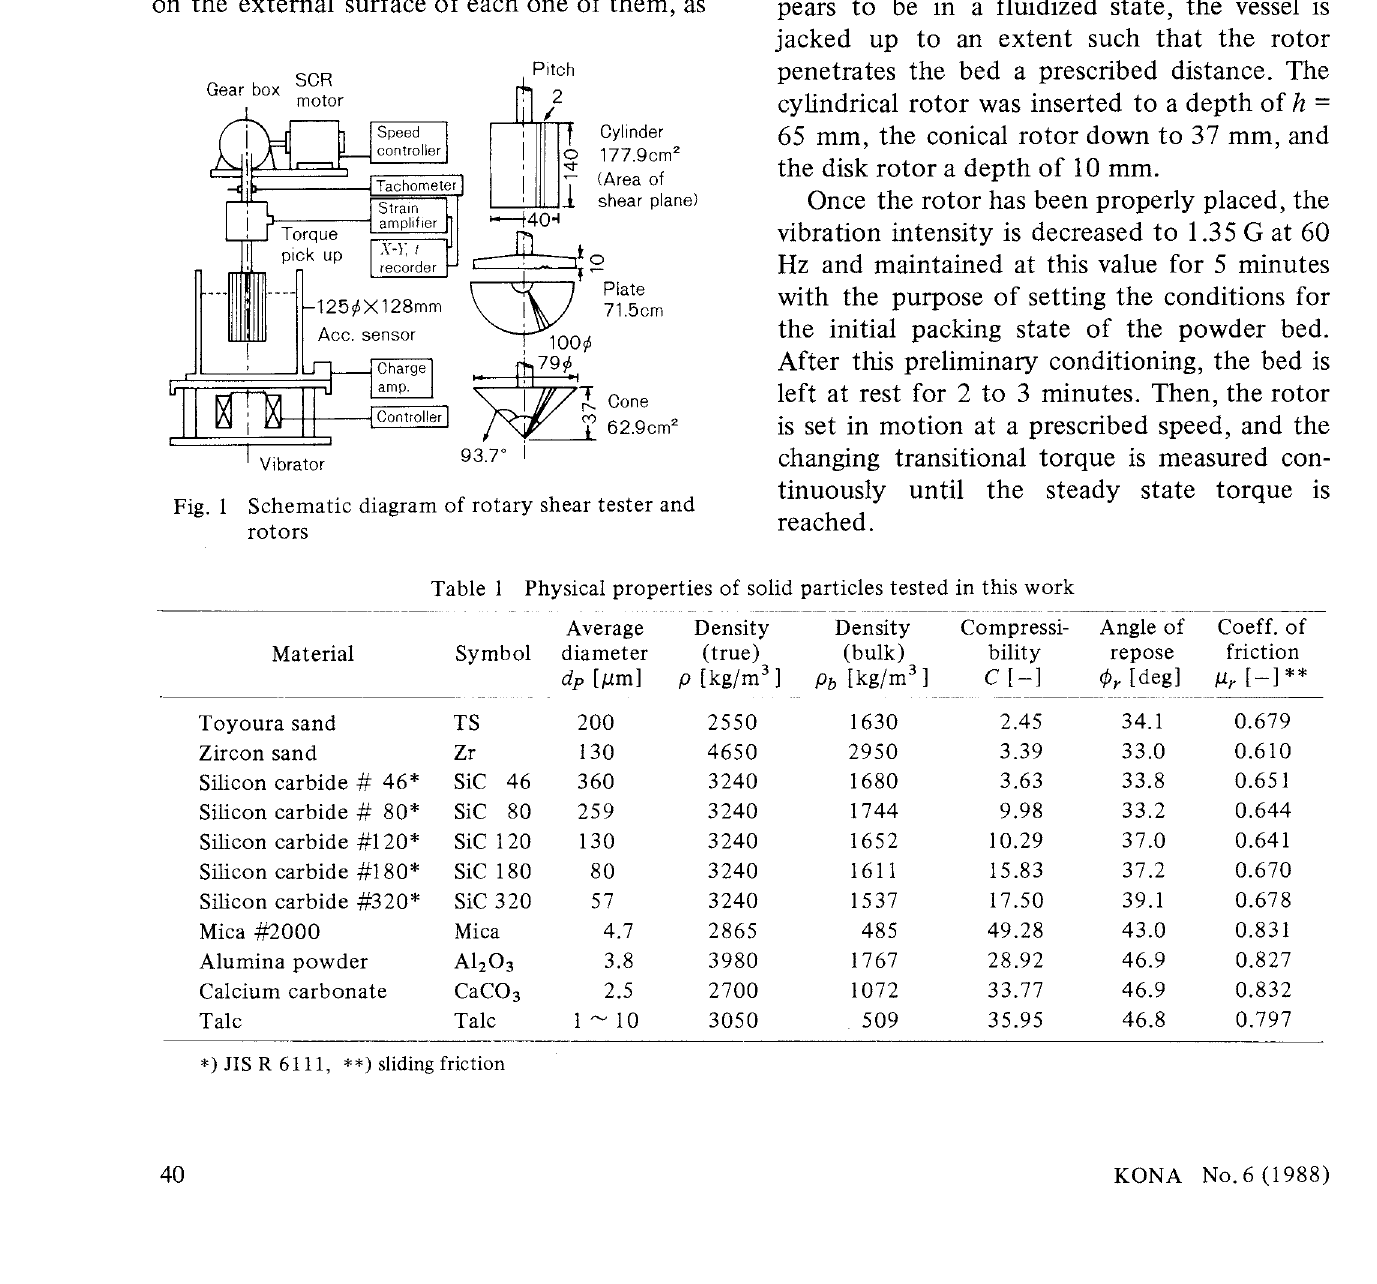
Fig. 1 Schematic diagram of rotary shear tester and rotors Table 1 Physical properties of solid particles tested in this